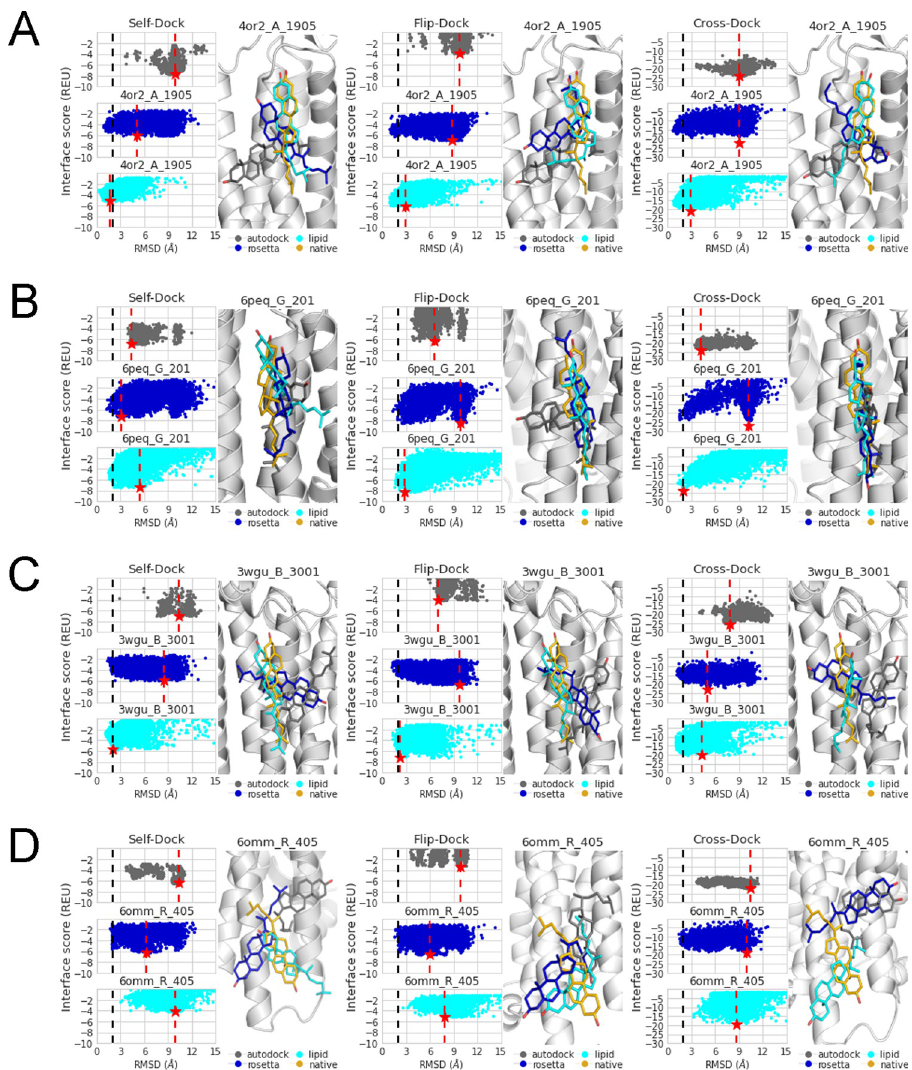
Fig 4. Illustrative examples of the best-scoring model in the self-dock, flip-dock, and cross-dock benchmarks. (A, B) RC (lipid) succeeds. (C,D) RC (lipid) fails. The co-crystal structure is shown (gold) aligned with the results from AutoDock (gray), RosettaLigand (blue), and RC (lipid, cyan). A black dotted line denotes the RMSD of 2 Å , and a red dotted line with a red star denotes the best-scoring